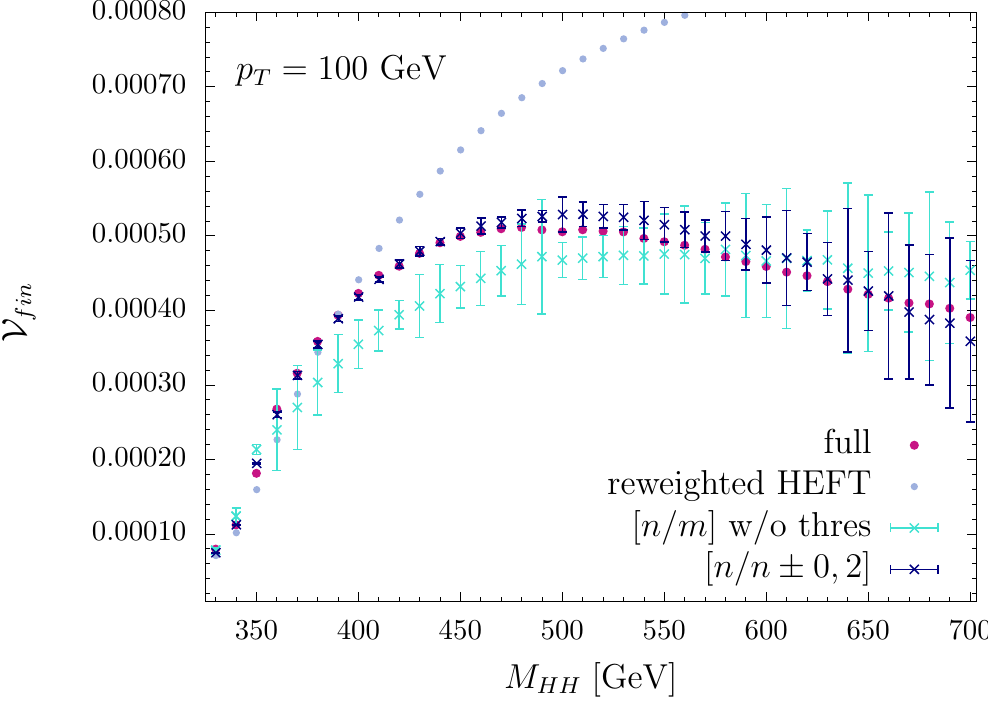
Figure 10 . Finite part of the virtual corrections, V (cid:12)n , as a function of M HH for p T = 100 GeV. The light blue points are the reweighted HEFT results, the pink points the virtual corrections in full top mass dependence from the interpolation function provided with ref. [90], the dark blue points are from the diagonal and o(cid:11)-diagonal Pad(cid:19)e approximants with their standard deviation and the turquoise points with standard deviation are the Pad(cid:19)e approximants constructed without the threshold